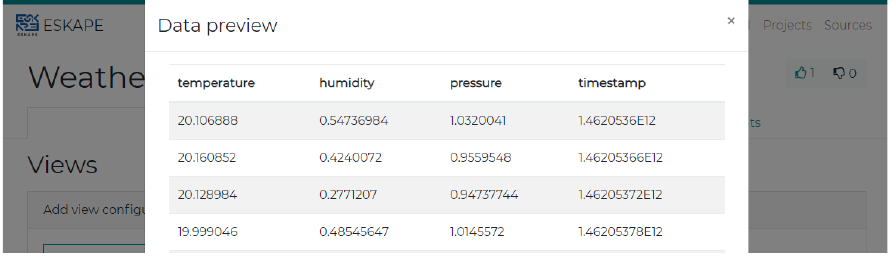
Figure 12. Preview window during data extraction using Hive views to query with external tools.